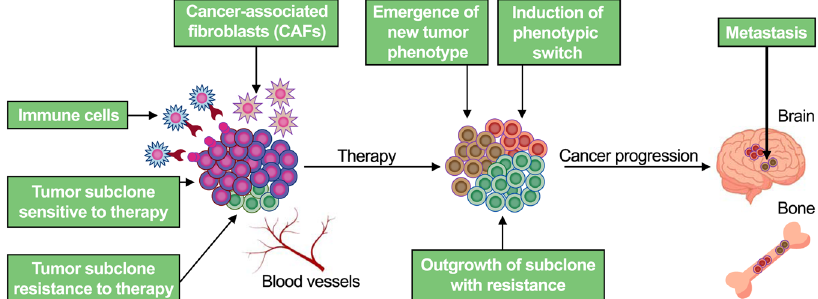
Fig. 3 Therapy-mediated tumor heterogeneity. Primary tumors are composed of different subclones. Some subclones are sensitive to selective pressures, including chemotherapy, androgen deprivation therapy, or immunotherapy, while some subclones are resistant to anticancer therapies. Outgrowth of resistant subclones, phenotype switch, or emergence of a new tumor phenotype are strongly related for resistance to anticancer therapies. As a result, the tumor heterogeneity plays a fundamental role in cancer progression to